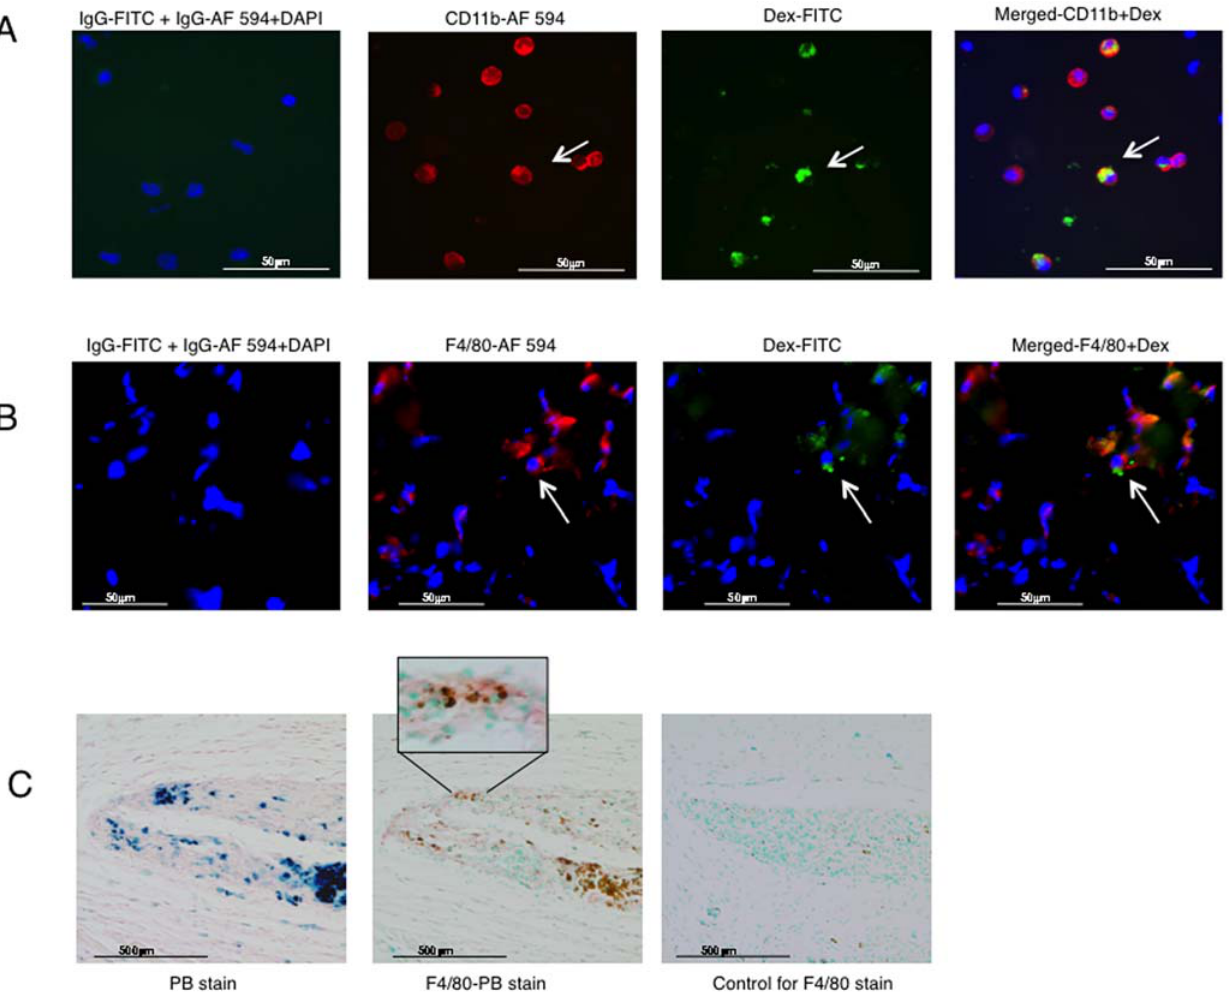
Figure 7. Immunofluorescent and Prussian Blue (PB) staining of Fe-Pro uptake by local infiltrating Matrigel TM plaque macrophages from Fe-Pro-labeled BMSCs. Representative immunofluorescent images showing detection of dextran (Dex) with anti-Dex-FITC, CD11b with anti- mouse CD11b-Alexa Fluor 594 on cytospins of cells recovered from MPs fourteen days post-implantation (magnification 40X), (A). On the merged image, note cells only positive for CD11b-Alexa Fluor 594 and macrophages positive for Dex-FITC and CD11b-Alexa Fluor 594. Those cells are local macrophages that took up Fe-Pro from Fe-Pro labeled hBMSCs. Immunofluorescent detection of Dex with anti-Dex-FITC, F4/80 with anti-mouse F4/ 80-Alexa Fluor 594 on frozen sections of MPs fourteen days post-implantation (magnification 40X), (B). Cells positive for macrophage marker, F4/80, as well as Dex are indicated by arrows. Immunohistochemical staining of MP sections showing colocalization of iron-positive cells (PB staining, blue or brown cells) and cells positive for macrophage marker, F4/80 (red cells) (C). Data are presented as a mean 6 1 SD from 12–18